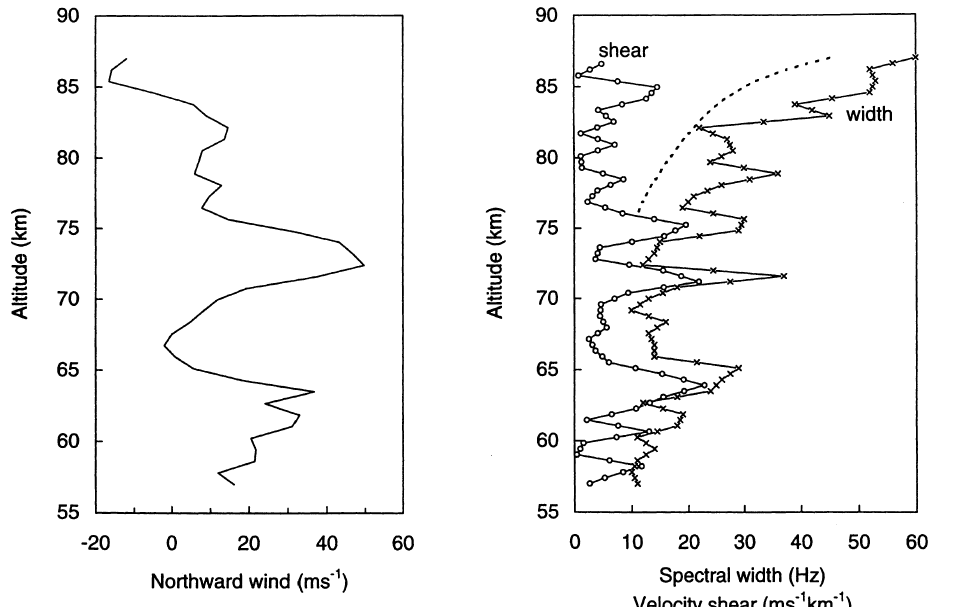
Fig. 3. Left: altitude profile of horizontal meridional wind measured with an antenna elevation angle of 50 (cid:176) at 0952 UT, 20 March 1990. The results are from analyses of 2-min integrations of the raw VHF